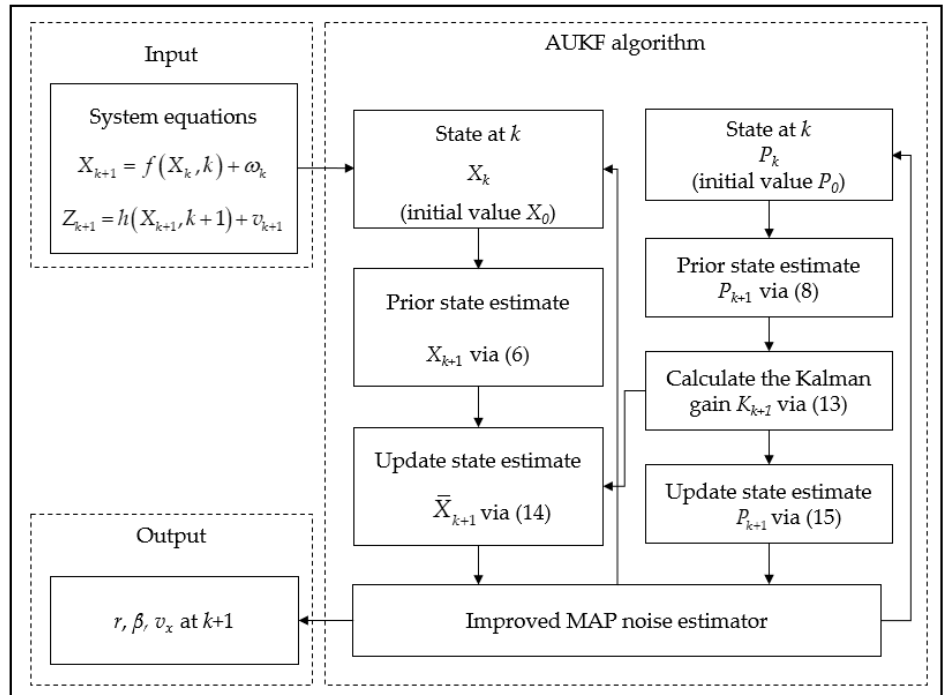
Figure 2. The framework of the AUKF algorithm.